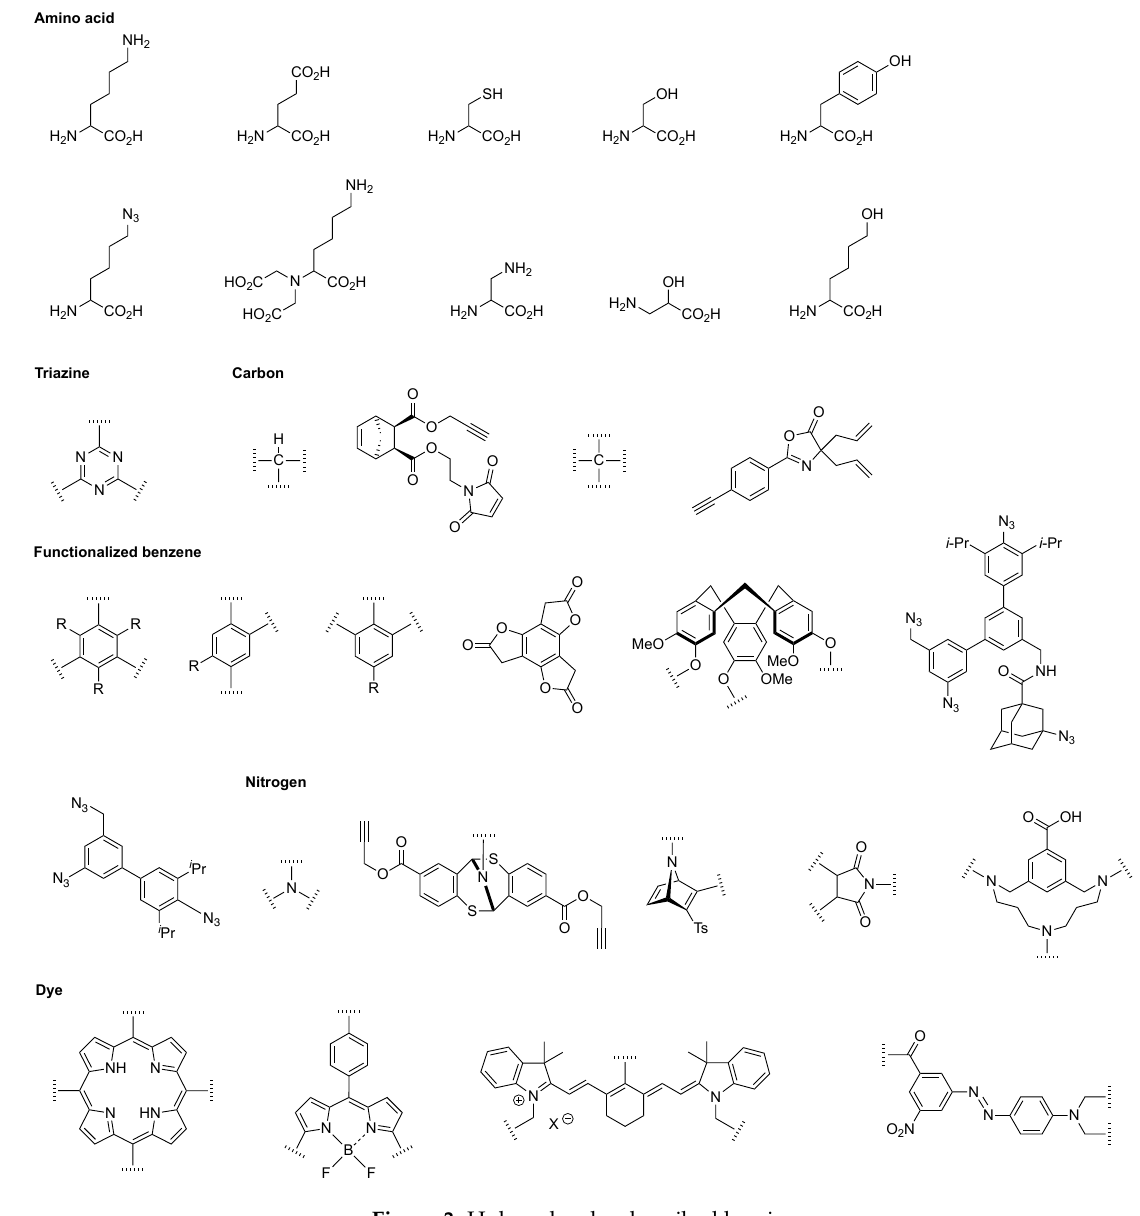
Figure 2. Structures of natural polysaccharide carriers and a synthetic dendrimer.